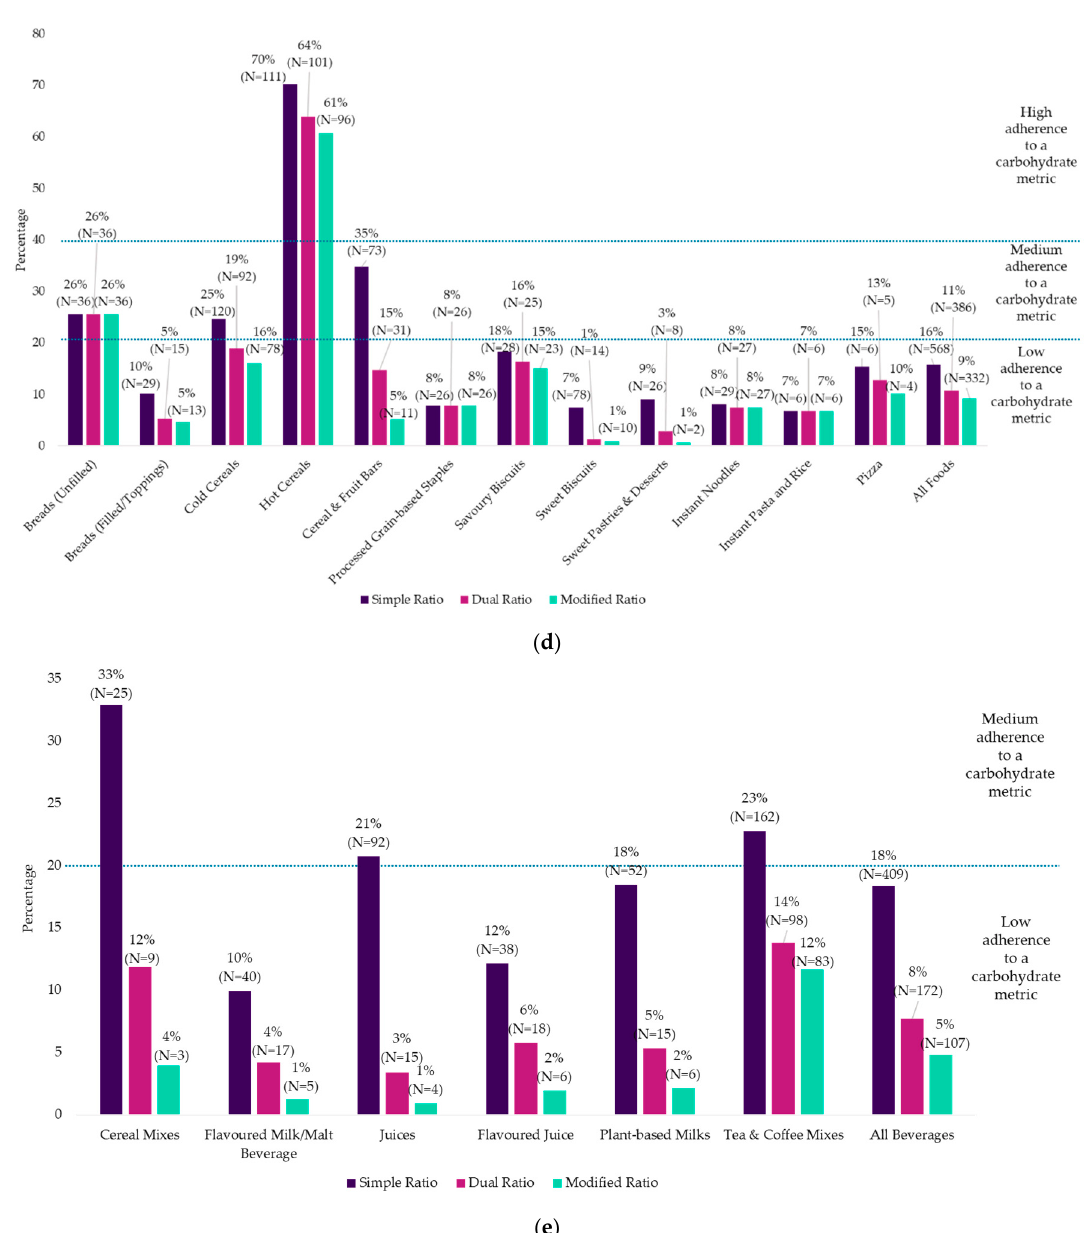
Figure 2. ( a ) Comparison of carbohydrate-based packaged food and beverage sub-categories from Figure 2. Percentage of carbohydrate-based packaged food and beverage sub-categories and products AFCD-1 that met each carbohydrate metric . The following categories were omitted from this graph from AFCD-1 and the Mintel Database that met each carbohydrate metric. ( a ) Comparison of as no sub-categories passed any metric: breads (filled/toppings), cereal and fruit bars, sweet biscuits, carbohydrate-based packaged food and beverage sub-categories from AFCD-1. The following categories sweet pastries and desserts, instant noodles, instant pasta and rice, pizza, cereal mixes, juices, were omitted from this graph as no sub-categories passed any metric: breads (filled / toppings), cereal flavoured juice, plant-based milks and tea and coffee mixes. ( b ) Comparison of carbohydrate-based and fruit bars, sweet biscuits, sweet pastries and desserts, instant noodles, instant pasta and rice, pizza, packaged foods from Mintel Australia that met each carbohydrate metric . ( c ) Comparison of cereal mixes, juices, flavoured juice, plant-based milks and tea and co ff ee mixes. ( b ) Comparison of carbohydrate-based packaged beverages from Mintel Australia that met each carbohydrate metric . carbohydrate-based packaged foods from Mintel Australia. ( c ) Comparison of carbohydrate-based NA indicates no products within the category from the respective database. ( d ) Comparison of packaged beverages from Mintel Australia. NA indicates no products within the category from carbohydrate-based packaged foods from Mintel Asia that met each carbohydrate metric . ( e ) the respective database. ( d ) Comparison of carbohydrate-based packaged foods from Mintel Asia. Comparison of carbohydrate-based packaged beverages from Mintel Asia that met each carbohydrate ( e ) Comparison of carbohydrate-based packaged beverages from Mintel metric .